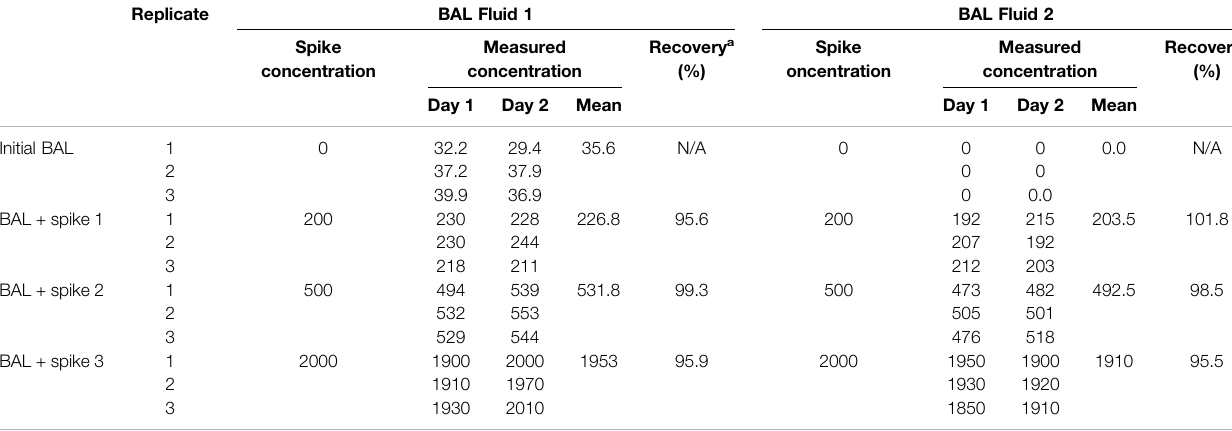
TABLE 1 | Accuracy and spike recovery of 8-isoprostane in BAL fl uid (pg/ml). Replicate BAL Fluid 1 BAL Fluid 2 Spike Measured concentration